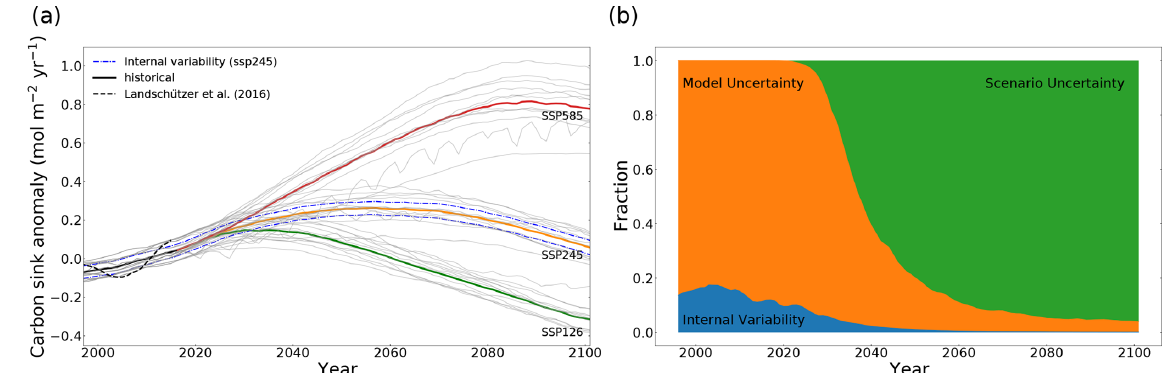
Figure 2. (a) Thick lines are multi-model means of the global mean ocean carbon sink anomaly time series relative to 1995–2015. Individual models are plotted as thin grey lines in the background. The black dashed line shows the Landschützer et al. (2016) SOM-FFN product. Both models and SOM-FFN time series are smoothed with a 10-year running mean. The blue dashed lines show internal variability for ssp245. (b) Time series showing the breakdown of uncertainty to different sources with time for the global ocean carbon sink anomaly. The internal uncertainty and model uncertainty are averaged for different scenarios.